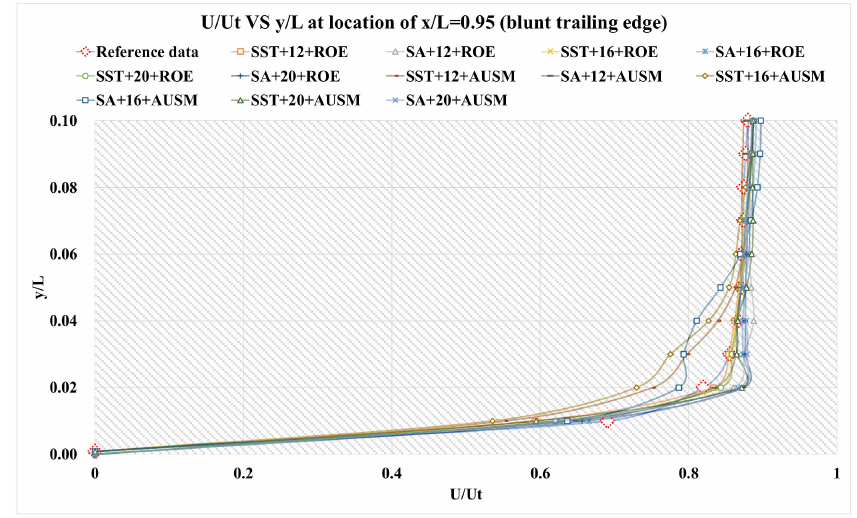
Figure 6. Distributions of U/U t of the blunt trailing edge at location of x/L = 0.95. Table 12. The mean error ratios of P/P t , T/T t , and U/U t of the blunt trailing edge.